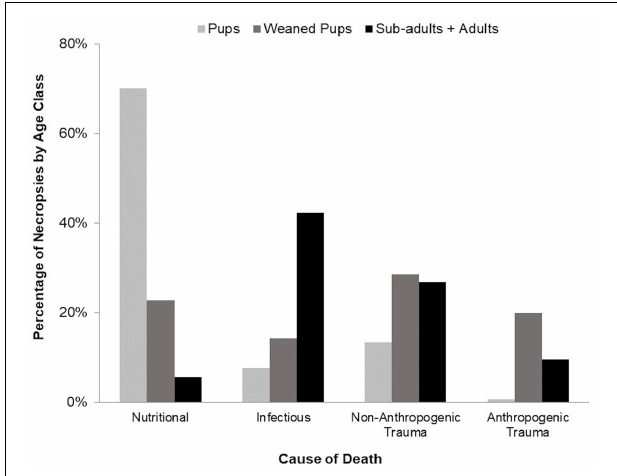
FIGURE 5 | Major cause of death categories by age class, which accounted for 89% of all deaths in necropsied harbor seals (144 of 157 pups, 30 of 35 weaned pups, 12 of 12 sub-adults, and 32 of 40 adults). Sub-adults are combined with adults due to the small sample